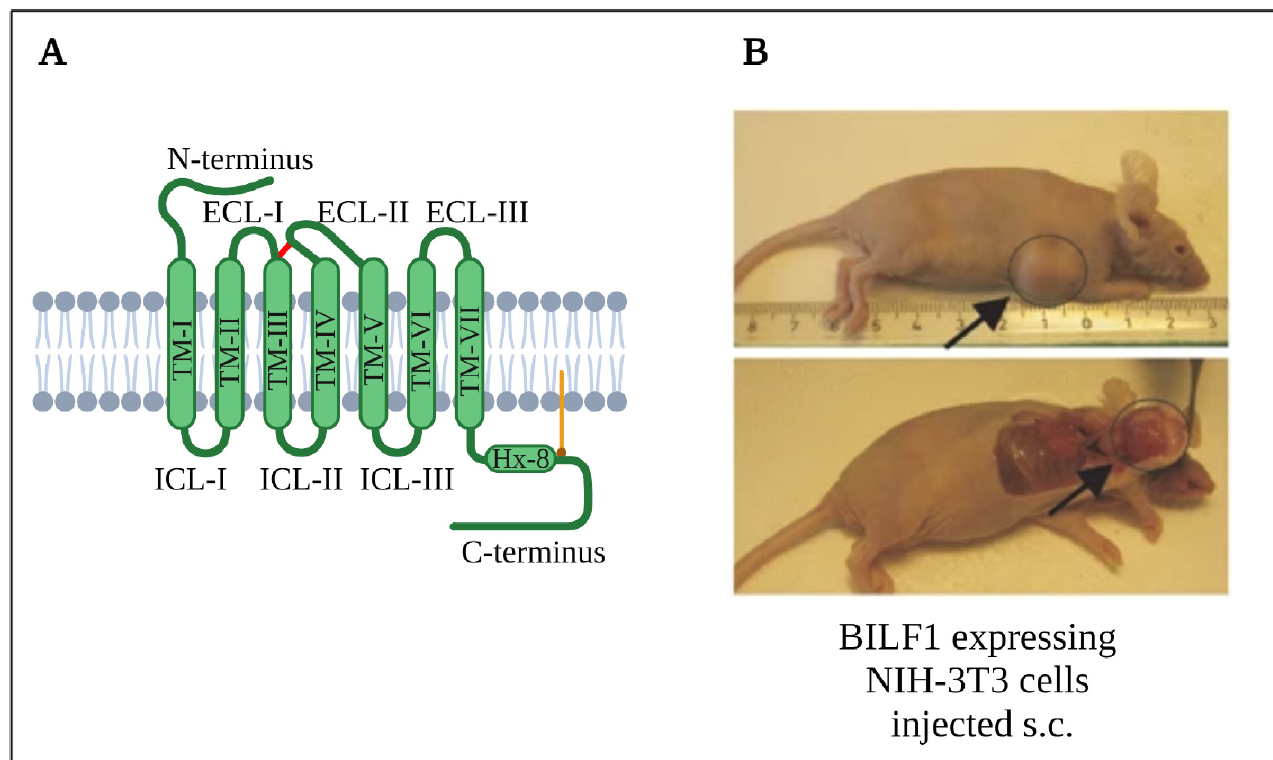
Figure 2. ( A ) Common structure of a class A G protein–coupled receptor (GPCR), such as BILF1. It shows the seven hydrophobic transmembrane (TM) helices, the linking intracellular (ICLs) and extracellular loops (ECLs), and a conserved disulfide bond (red) between TM-3 and ECL-2, Helix 8 and a palmitoylation in orange. ( B ) BILF1 expressing NIH-3T3 cells injected s.c. form tumors in a nude mouse model [122]. Created with BioRender.com